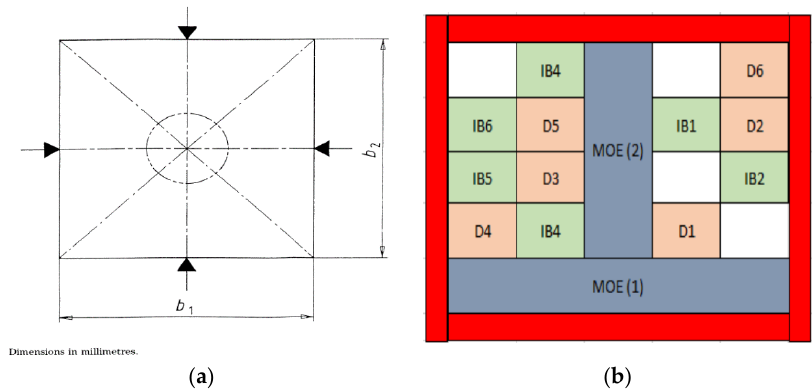
Figure 6. ( a ) Point of Measurement; ( b ) Test piece chosen from a sample board.